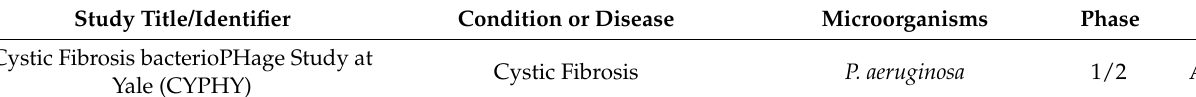
Table 1. Current active or recruiting clinical trials involving phage